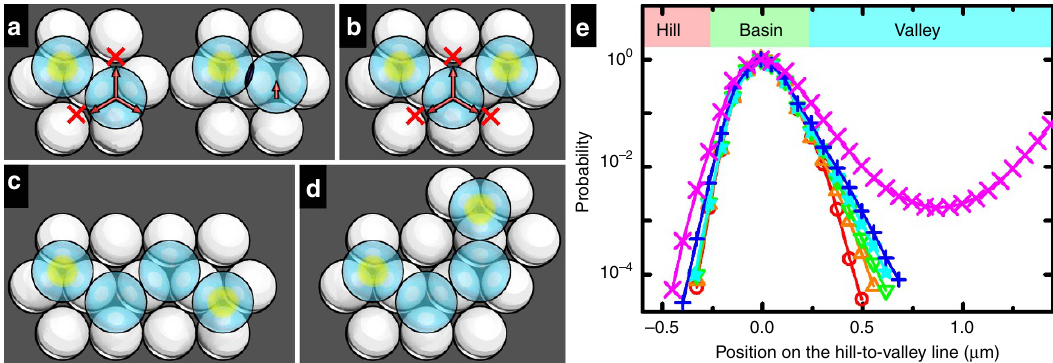
Figure 7 | Stability of vector structures. ( a – d ) 2-particle, 3-particle, trans -4-particle and cis -4-particle configurations with the optical tweezers as the yellow circles. Blocked hopping routes are highlighted in a , b . ( e ) Positional probability along the hill-to-valley line with red, orange, green, cyan, blue and magenta points corresponding to optical tweezer holding, 3-particle, trans -4-particle, cis -4-particle, 2-particle and free configurations, respectively. Side and top views of the lowest surface that the top particle centre can explore. The red dash line is defined as the hill-to-valley line with hill, basin and valley regions indicated by different